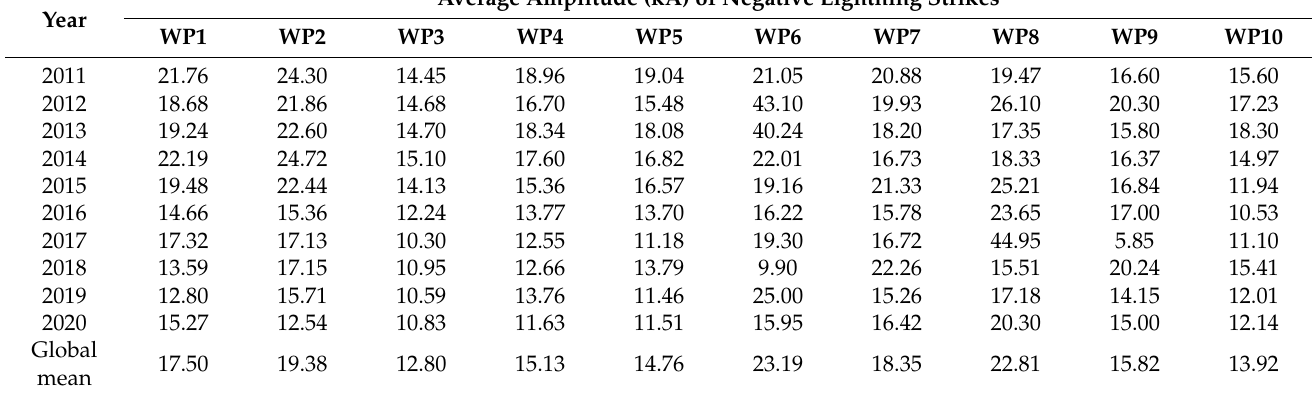
Global mean Table 7. Annual average amplitude (kA) of the recorded negative lightning strikes per wind park (observation period